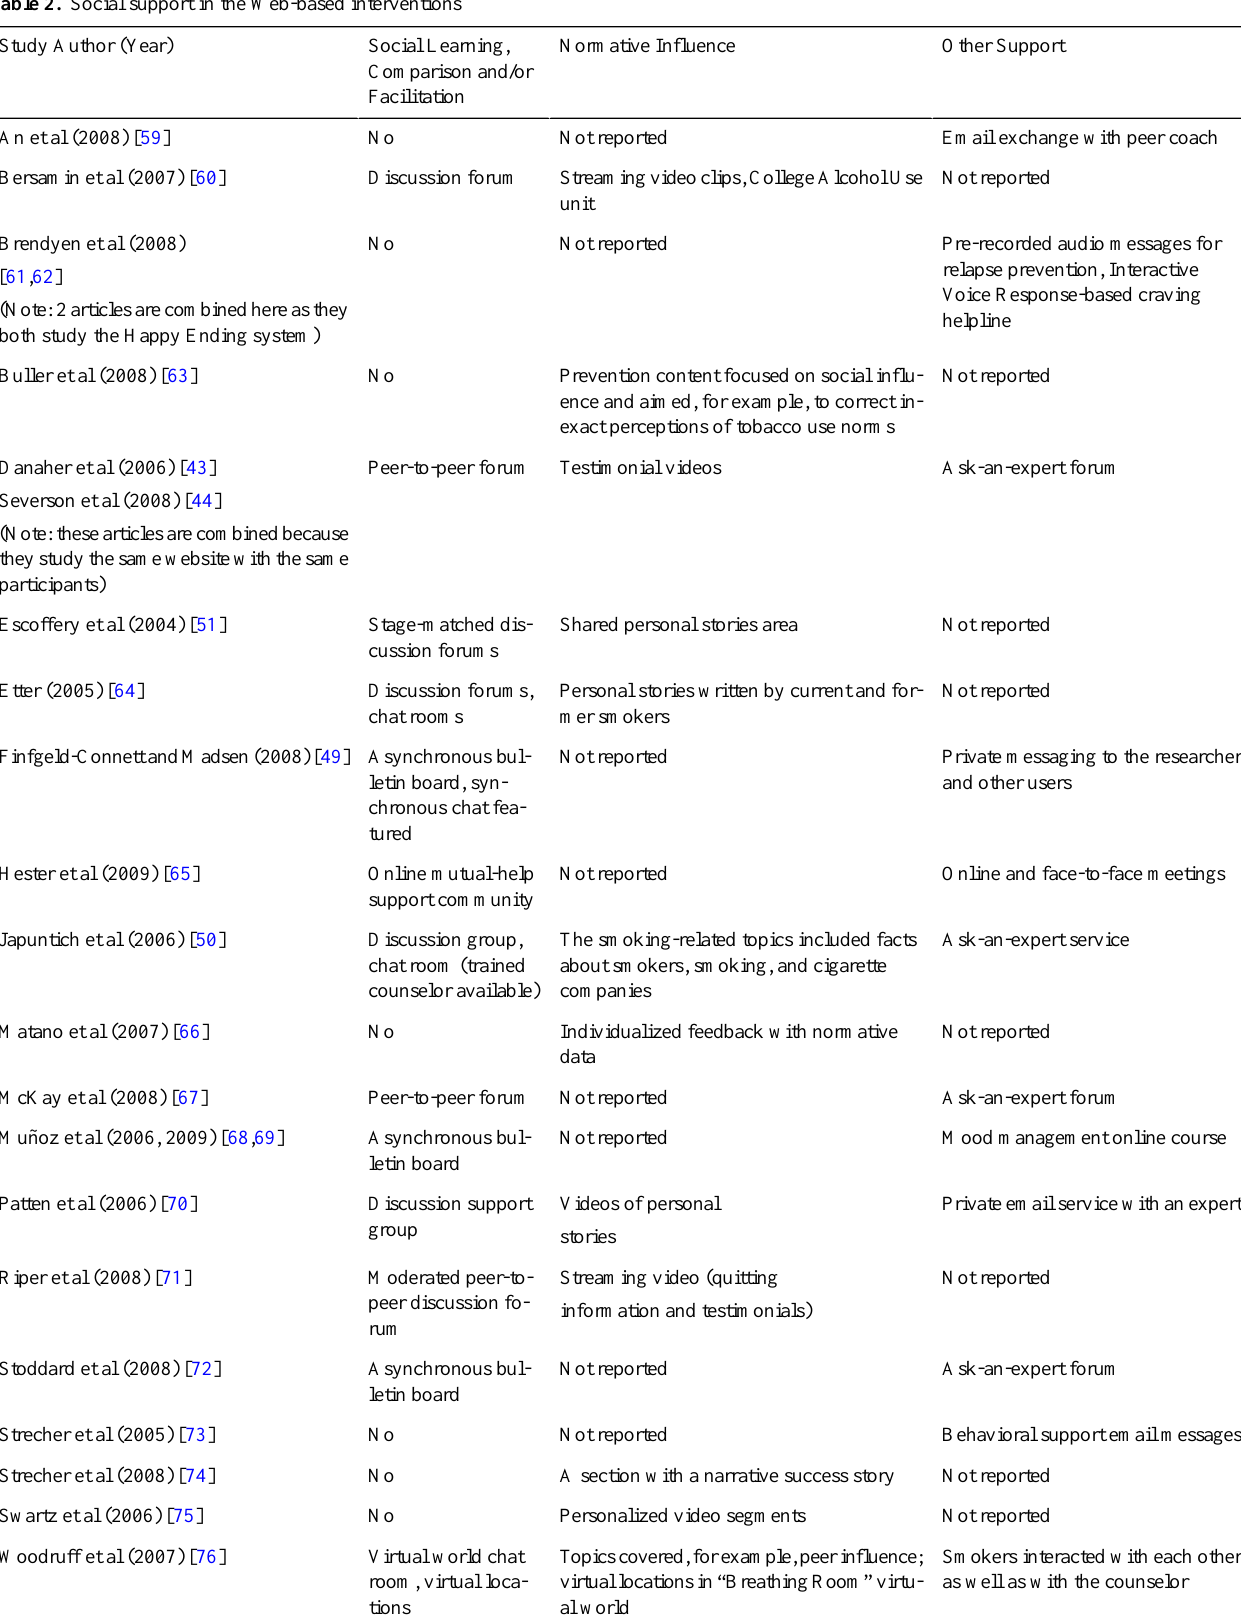
Table 2. Social support in the Web-based interventions